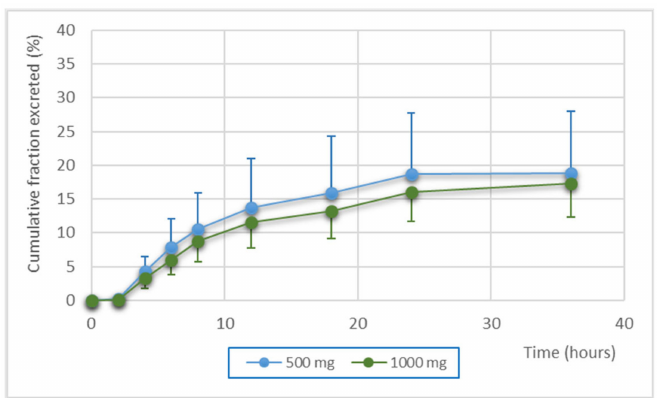
Figure 1. Cumulative fraction of administered dose recovered in urine (mean and standard deviation) after a single administration of 500 mg or 1000 mg.